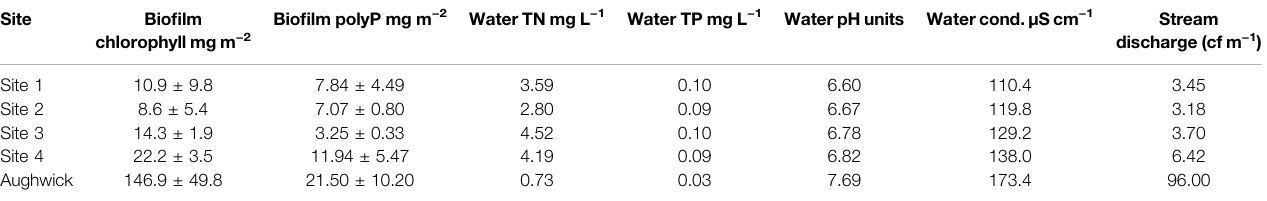
TABLE 1 | Initial biogeochemical conditions at fi ve stream sites in the Mid-Atlantic region of the United States where experiments were carried out. Four sites were located along an upstream to downstream reach (Site one to Site four) in the FD-36 watershed and one site in Aughwick Creek watershed (14 July 2014). Naturally occurring bio fi lmsweresampledon14July2014fromstreamrocks andwaterchemistrywasmeasuredfromgrabsamplescollectedonseveraldates(17,23,and30July2014)prior to the initiation of experiments. Discharge was measured for the entire during daily over the entire day of the experiment.